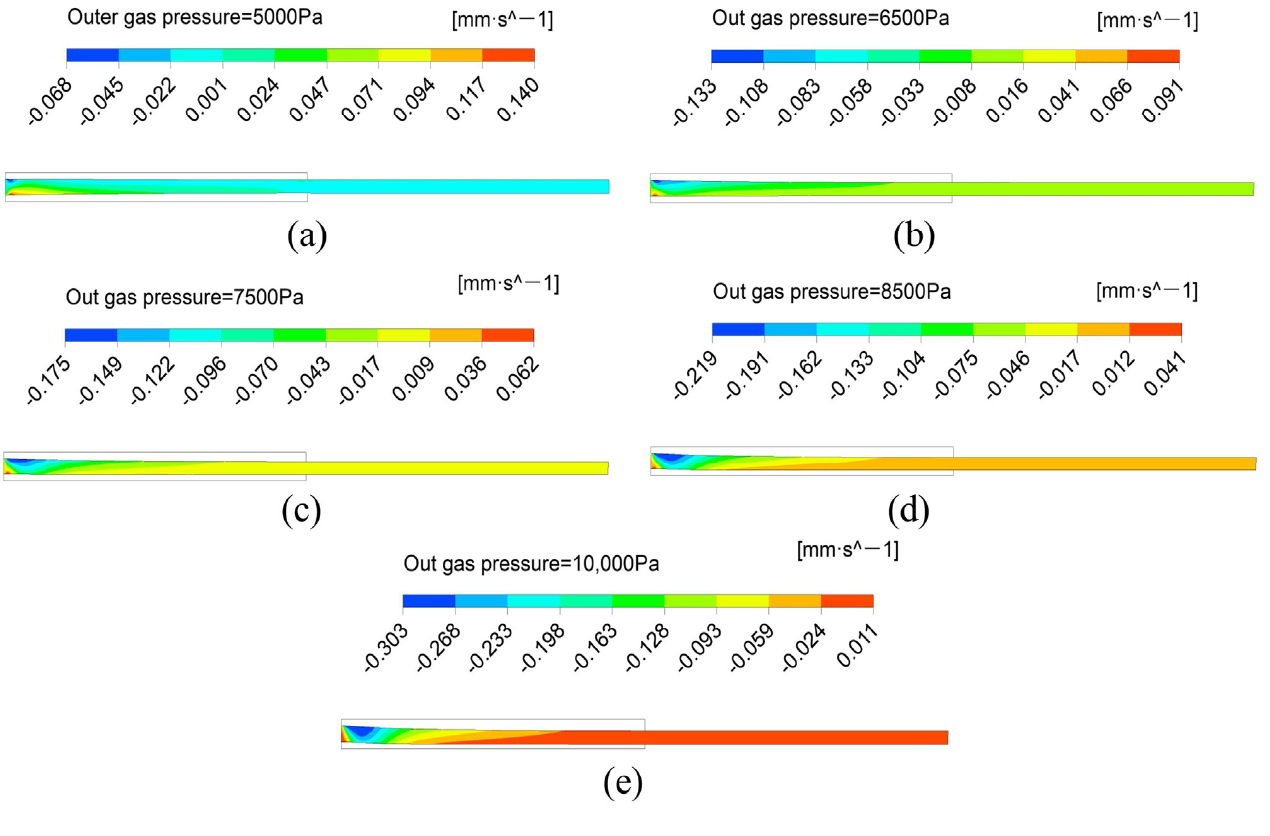
Figure 4. The distribution of melt radial velocity under different pressure of the outer gas cushion layer.( a ) The pressure of the outer gas layer is 5000 Pa; ( b ) The pressure of the outer gas layer is 6500 Pa; ( c ) The pressure of the outer gas layer is 7500 Pa; ( d ) The pressure of the outer gas layer is 8500 Pa; ( e ) The pressure of the outer gas layer is 10,000 Pa.